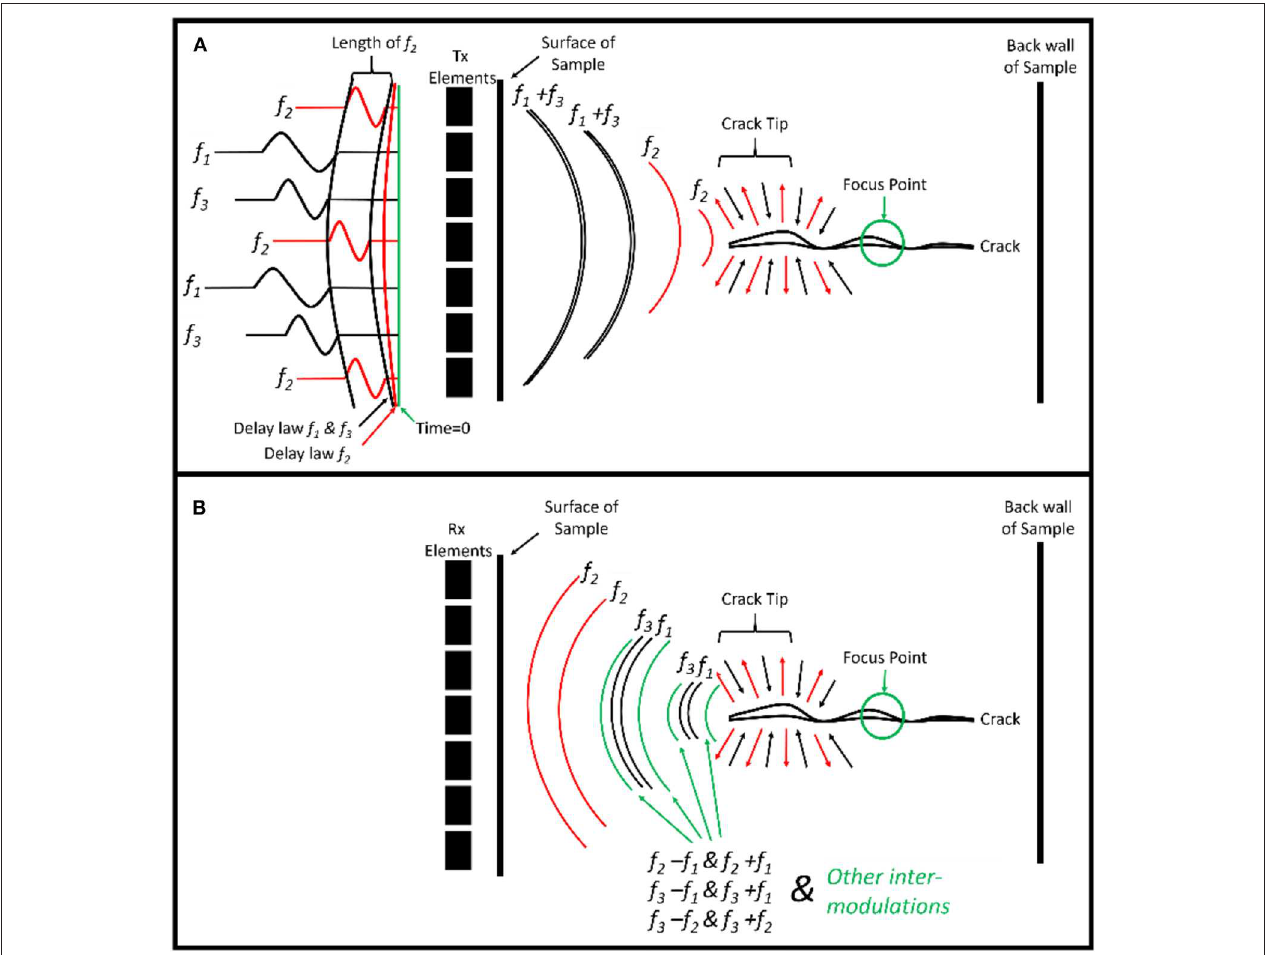
FIGURE 2 | Example of delay laws, excitation signals and wave propagation for: (A) transmitted (Tx) and (B) received signals (Rx), for a tri frequency excitation through the thickness of a damaged sample.